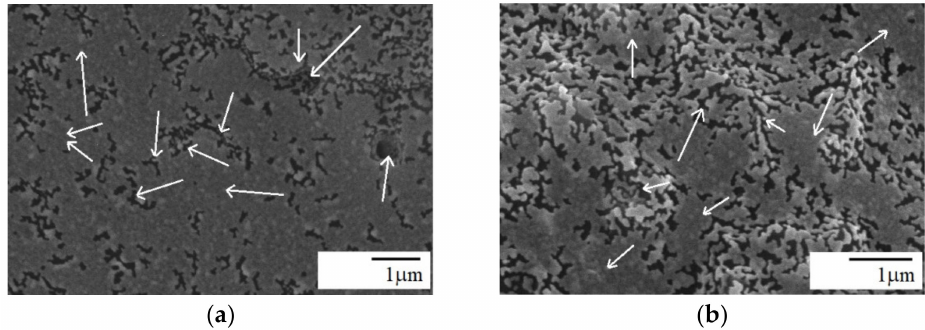
Figure 5. Nitric-acid-etched SEM micrographs of PPO/PA11/A-SiO 2 80/20/5 composite: ( a ) low magnification, ( b ) high magnification; arrows—silica particles; all images were reported at scales of 1 µ